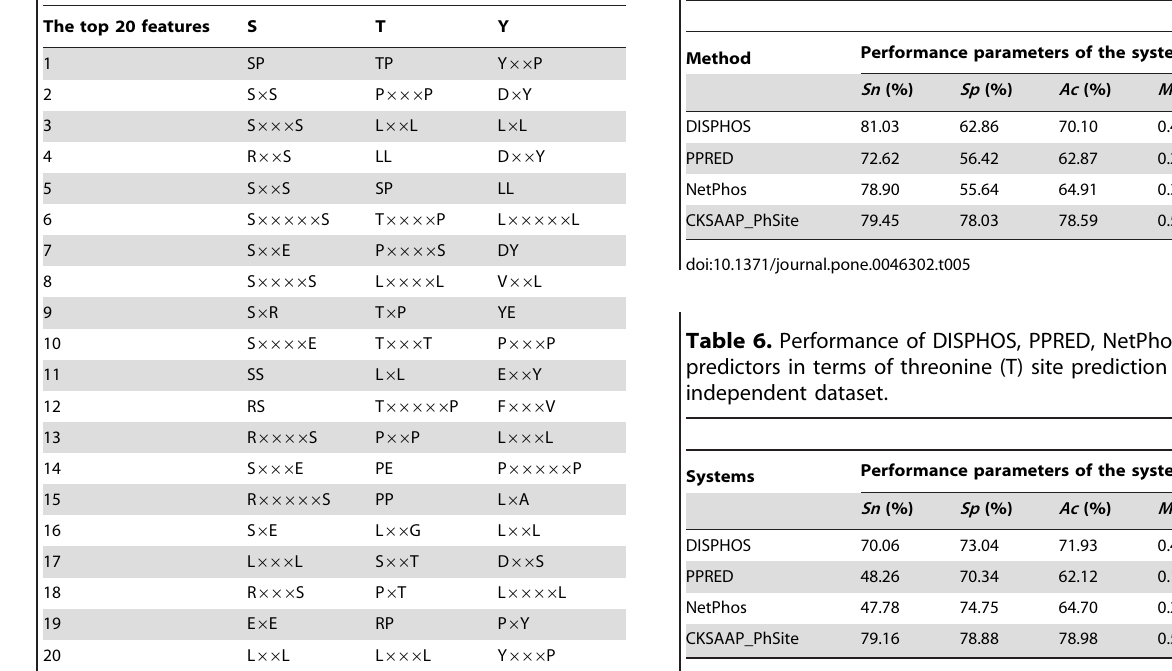
Table 5. Performance of DISPHOS, PPRED, NetPhos, and our predictors in terms of serine (S) site prediction on the independent dataset.